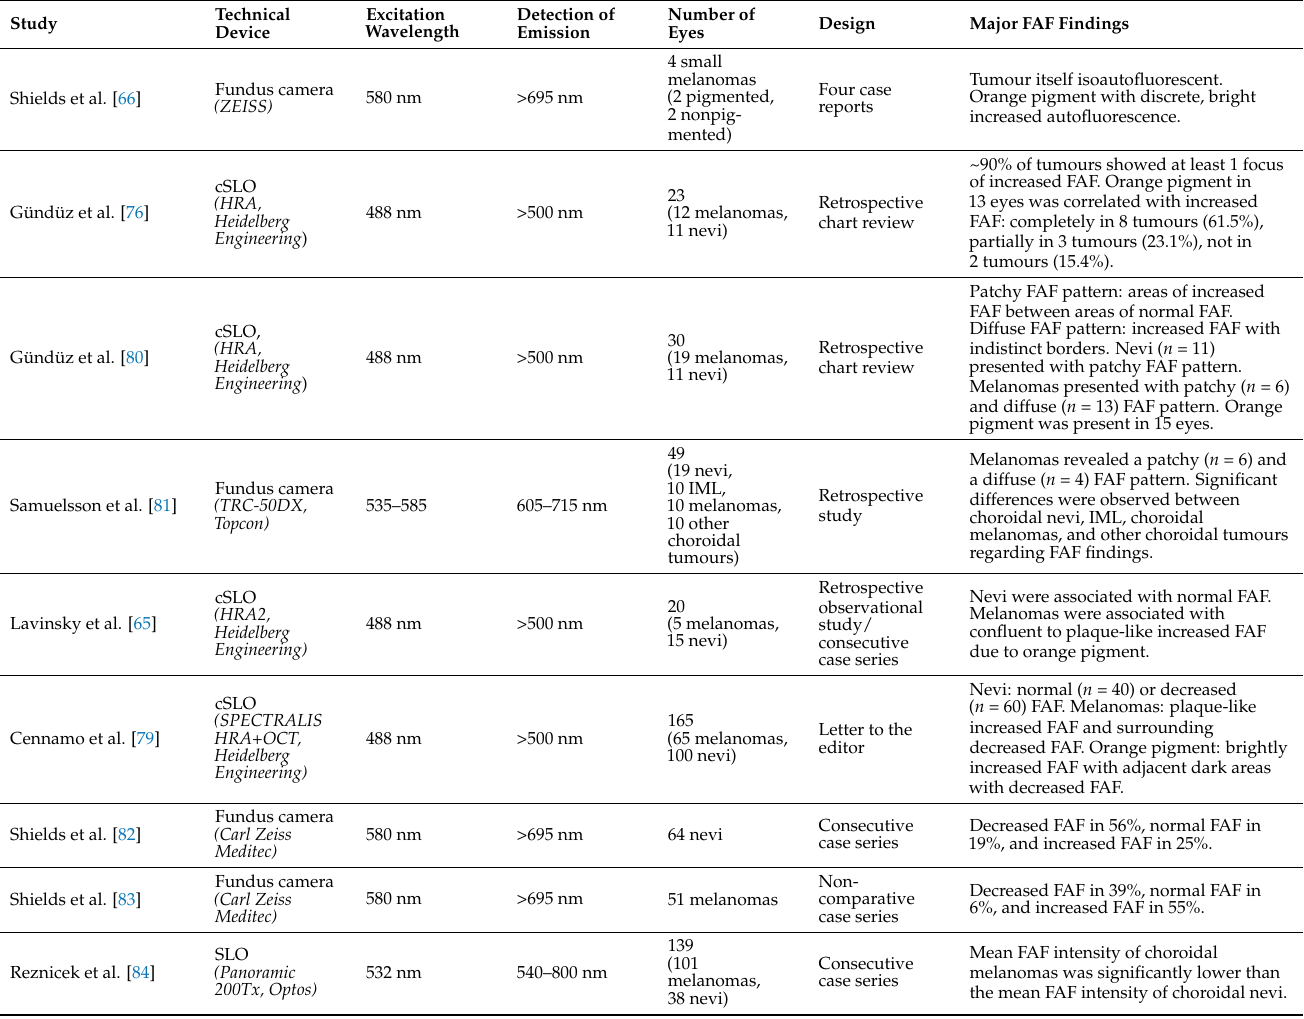
FAF: fundus autofluorescence. cSLO: confocal scanning laser ophthalmoscope; SLO: scanning laser ophthalmo- scope; IML: indeterminate choroidal melanocytic